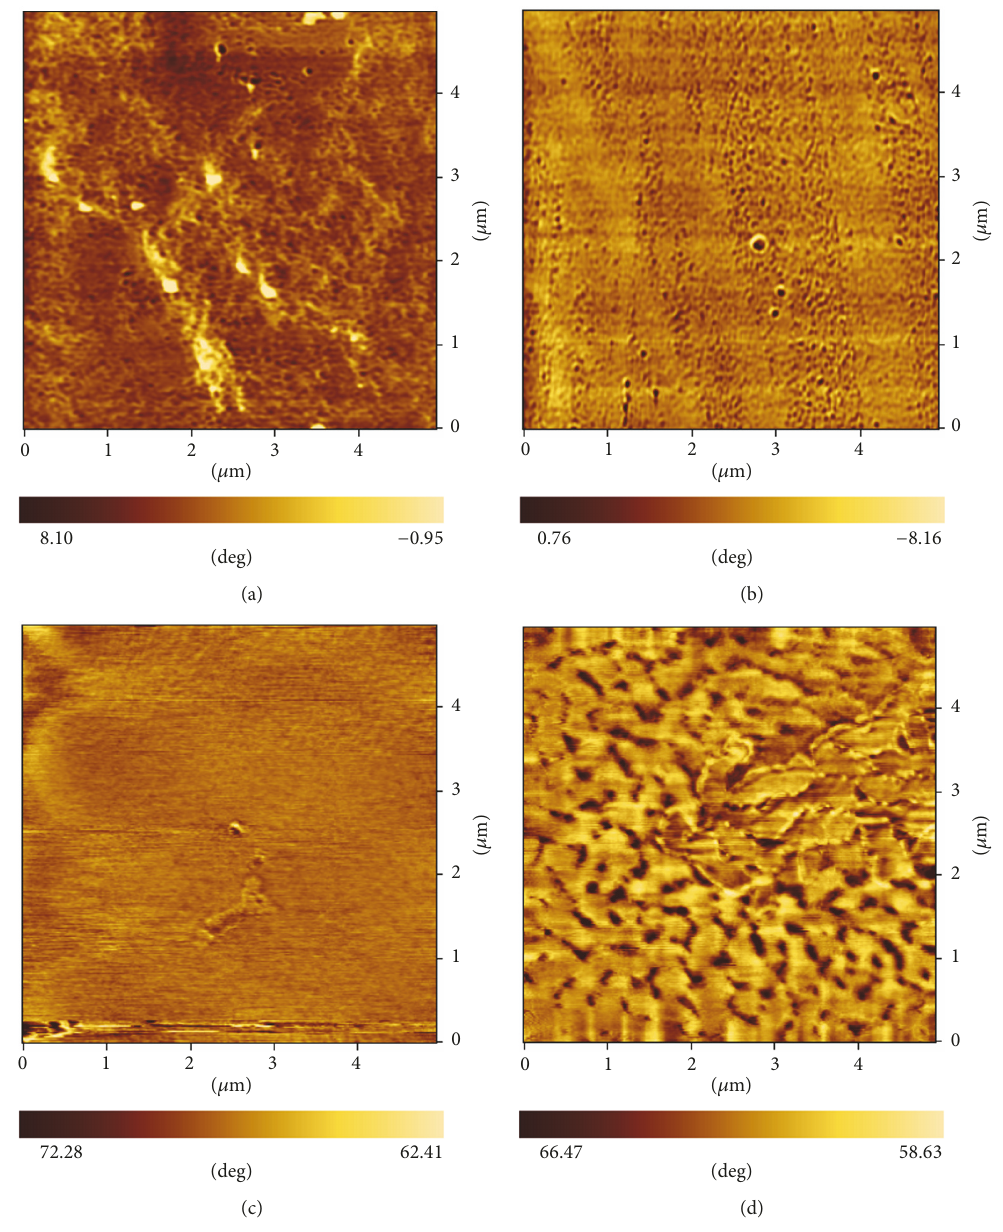
Figure 7: AFM images of the organic thin films: (a) PEDOT:PSS, (b) PEDOT:PSS/spin TPBi, (c) release film/spin TPBi, and (d) PEDOT:PSS/RF stamp